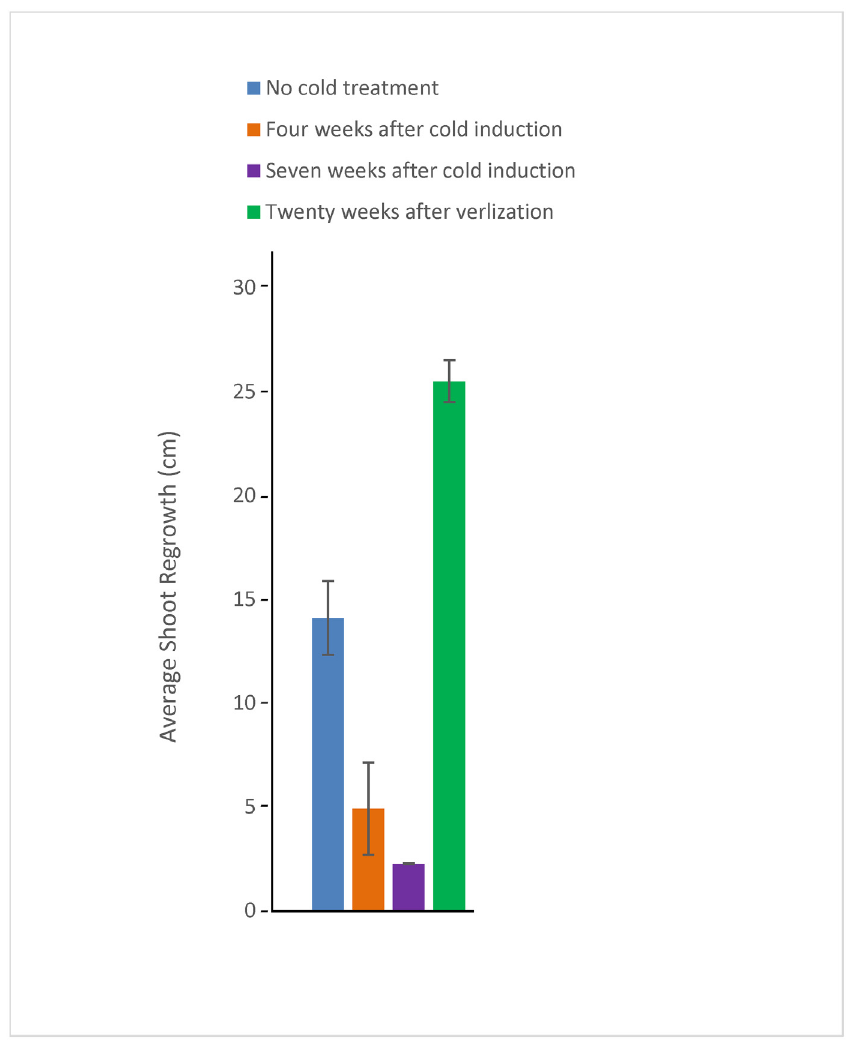
Fig 3. Comparison of the crown bud regrowth after 0, 4, or 7 weeks of endodormancy-inducing conditions. After the designated time points following dormancy induction or following vernalization, the aerial parts of the plants were removed, and the excised plants were grown in greenhouse for two weeks. Above chart only shows the average length of the longest shoots growing from crown buds after 0 through 7 weeks of endodormancy-inducing treatment and after twenty weeks vernalization. Error bars show range of the average of the longest stem from 7 plants for each